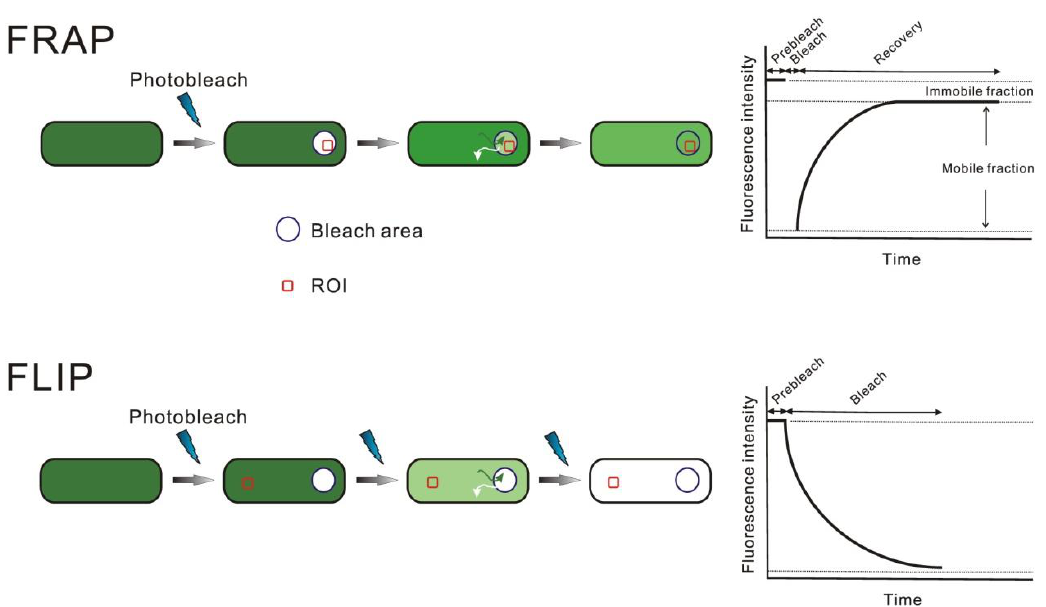
Figure 1. In FRAP, the fluorophores in a region of the cell (blue circle) are selectively photobleached. Fluorescence recovery in that region is assessed quantitatively by monitoring the intensity changes in the region of interest, ROI (red). Kinetics and mobile fraction can be calculated. In FLIP, a region of the cell is photobleached, sometimes repeatedly. The loss of fluorescence from an outside area (red ROI) is monitored. These methods can be used to estimate mobility and kinetic